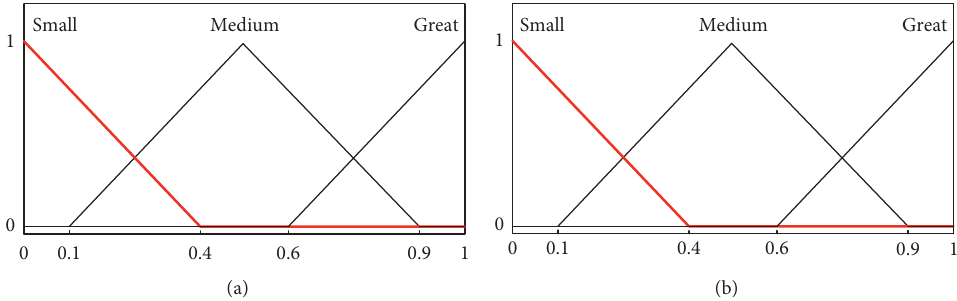
Figure 24: (a) FV membership functions for LV h r : “height”; (b) FV membership functions for LV b r : “width”.